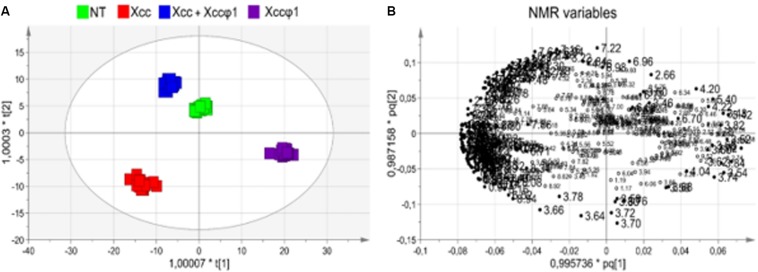
Metabolomic analysis (OPLS-DA of NMR data) of leaf extracts from B. oleracea var. gongylodes treated with Xcc and Xcc + Xccφ1. (A) Scores plot (97%, p < 0.0001) showing the separation of the treatments: NT (water); Xcc (bacteria alone); Xcc + Xccφ1 (Xcc plus Xccφ1 phage); Xccφ1 (phage alone). R2 was 0.97 and Q2 was 0.96. (B) Loadings plot associated with the OPLS-DA analysis reported in (A), indicating determining NMR variables. Numbers refer to buckets’ chemical shifts (spectral positions), and their size indicated the more discriminating buckets. The pq[1] and pq[2] values refer to the weight that combines the X and Y loadings (p and q).